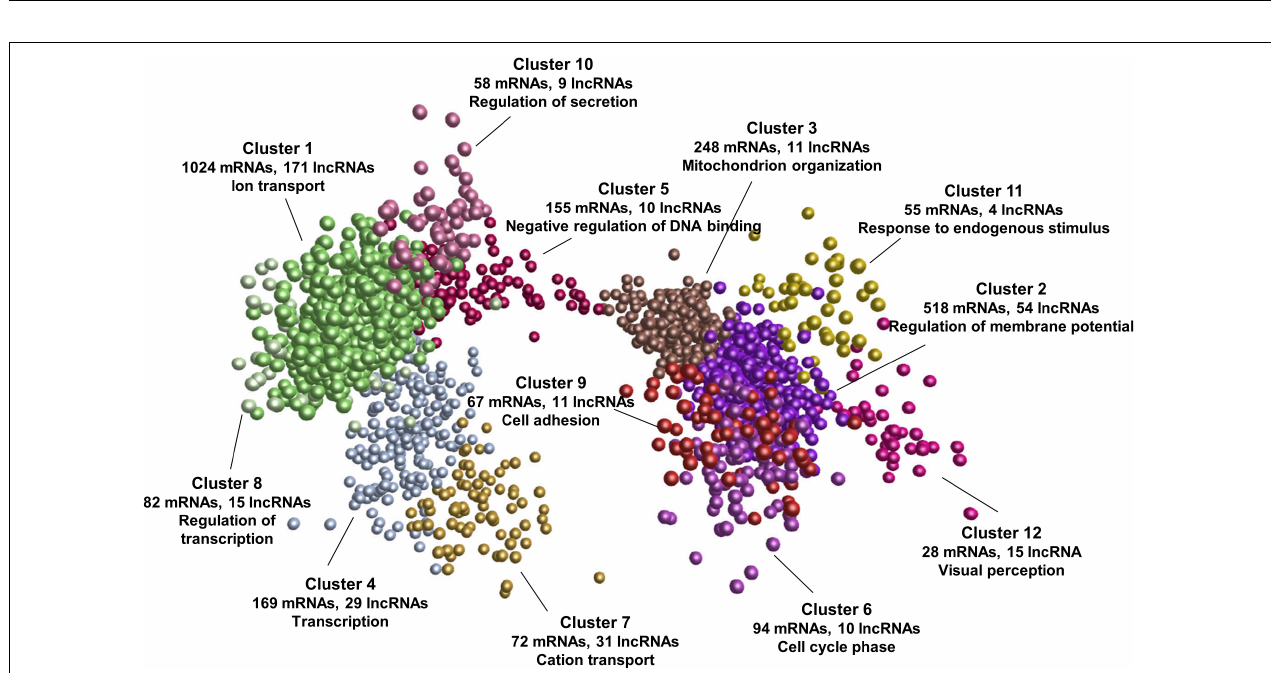
FIGURE 5 | mRNA-lncRNA co-expression network. All the differentially expressed mRNAs and lncRNAs were used to construct the co-expression network by Biolayout Express (3D). The number of mRNAs/lncRNAs in each co-expression cluster and the most significantly enriched GO biological process of each cluster were